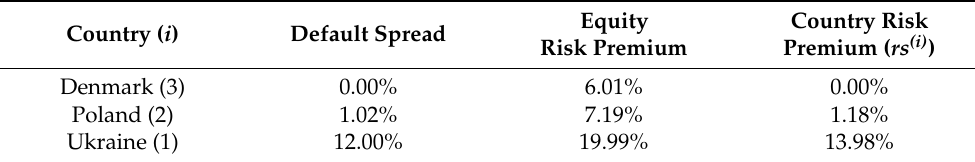
Equity Country Risk Risk Premium Premium ( rs (i) )